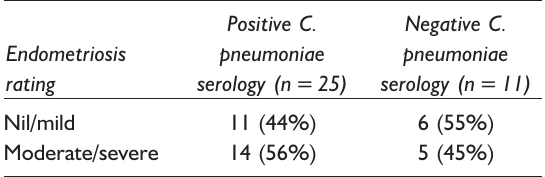
Table 3 Correlation of C. pneumoniae serology with endometriosis rating: numbers (%) of cases